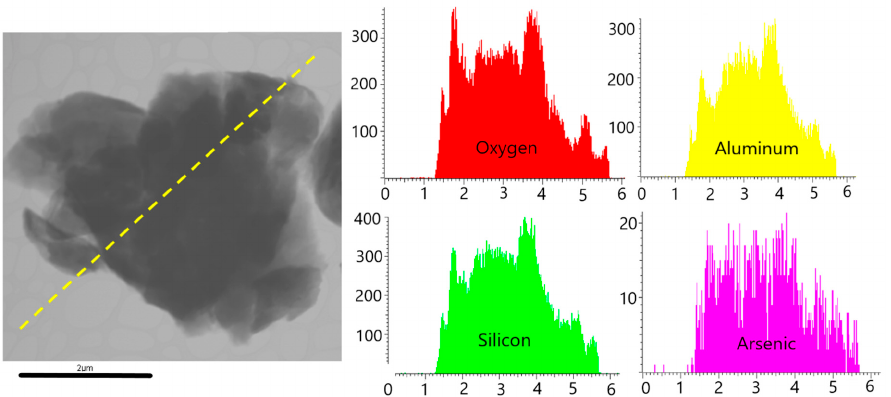
Figure 5. HR-TEM image of a clayey particle in sample R2. The yellow line indicated the section of the analysis. Graphs on the right show the distribution of O, Al, Si, and As. Note the difference between the vertical scales of the elements’ graphs.